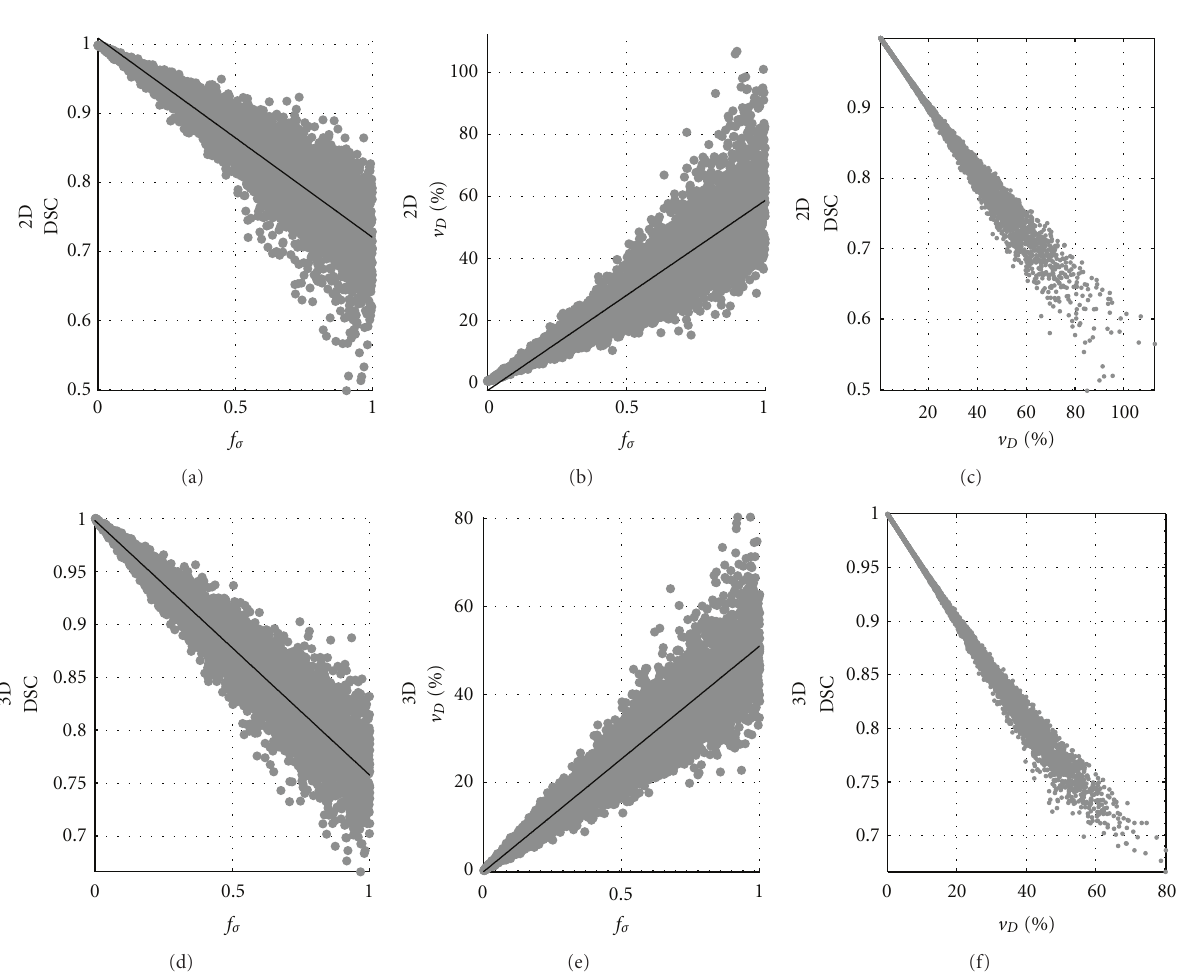
Figure 5: (a, d) DSC and (b, e) v D for all the 6250 rater images of the (a, b) 2D and (d, e) 3D testing sets as a function of f σ . A linear fit was performed for both scatter plot types (black) showing the quasilinear relationship between f σ and both DSC and v D . (c, f) DSC plotted as a function of v D . We see that the scatter plots also follow a quasilinear trend. This graph demonstrates that, compared to a point with given v D and DSC, a neighbor point with a higher (worse) v D can still give a higher (better) or similar DSC, especially for high v D , questioning the validity of DSC as a performance measure for label